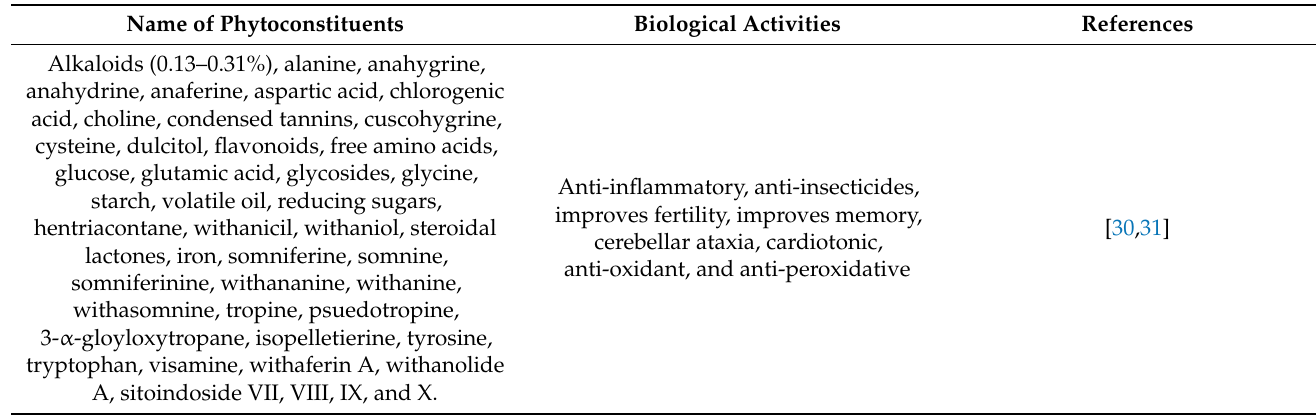
Table 3. Different biological compounds present in roots and their activities.